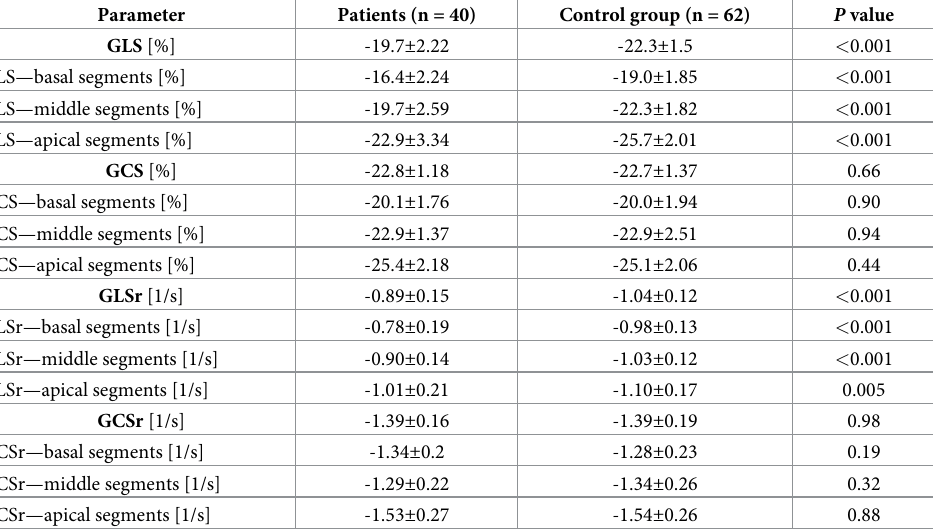
Data expressed as mean+SD. GLS, global longitudinal strain; LS, longitudinal strain; GCS, global circumferential strain; CS, circumferential strain; GLSr, global longitudinal strain rate; LSr, longitudinal strain rate; GCSr, global circumferential strain rate; CSr, circumferential strain